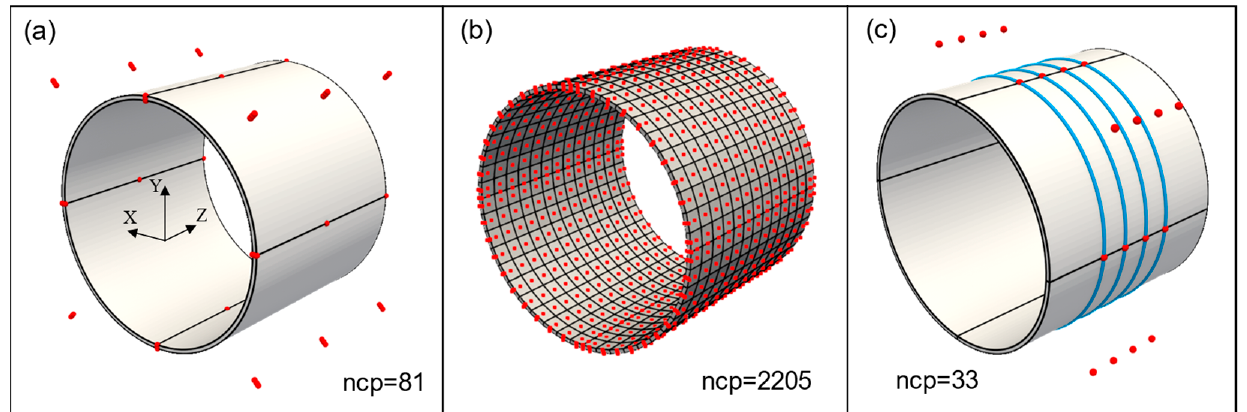
Figure 10. ( a ) Pipe geometry and control points (red). Black lines show C 0 continuity; ( b ) Analysis mesh and control points after h-refinement; ( c ) fiber geometry (blue) and fiber control points (red).